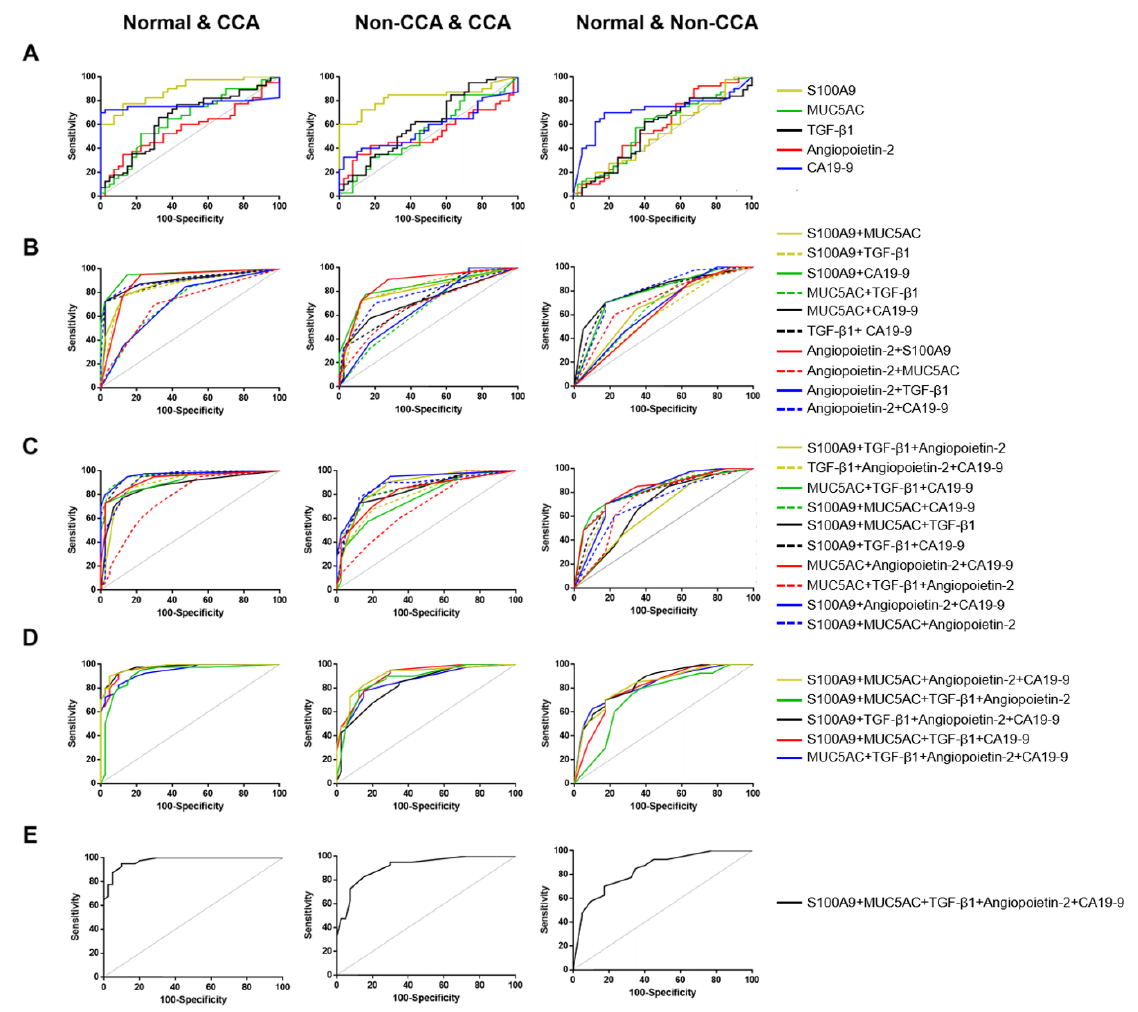
Figure 3. Receiver operating characteristic curve (ROC) analysis of single biomarker ( A ), two biomarkers ( B ), three biomarkers ( C ), four biomarkers ( D ), and combined five biomarkers panel ( E ) for each pairwise comparison including normal versus CCA (left), normal versus non-CCA (middle), and CCA versus non-CCA (right). Gray solid line: theoretically perfect performance of a potential biomarker as the reference line. Area under ROC curve (AUC) and statistic comparison are indicated. The p value < 0.05 was considered statistically significant.